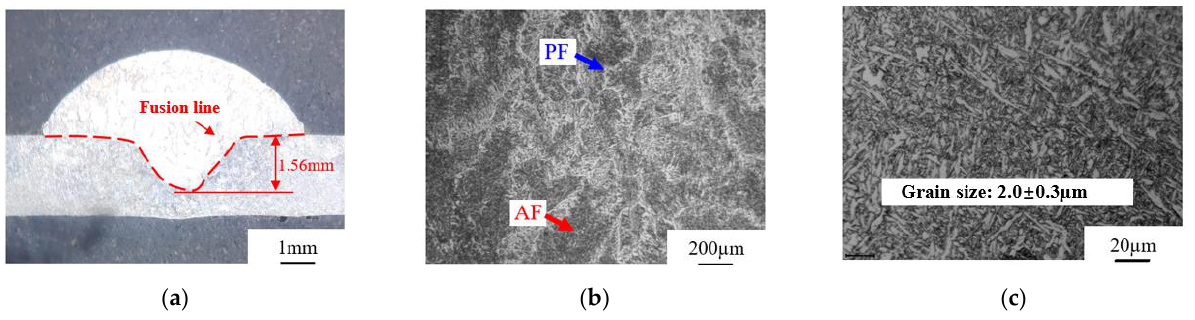
Figure 23. Morphology and structure of weld ( I = 100 A, exponential pulse waveform): ( a ) macro- scopic morphology of weld; ( b ) microstructure at the center of the weld; ( c ) high magnification im- age of the AF phase.